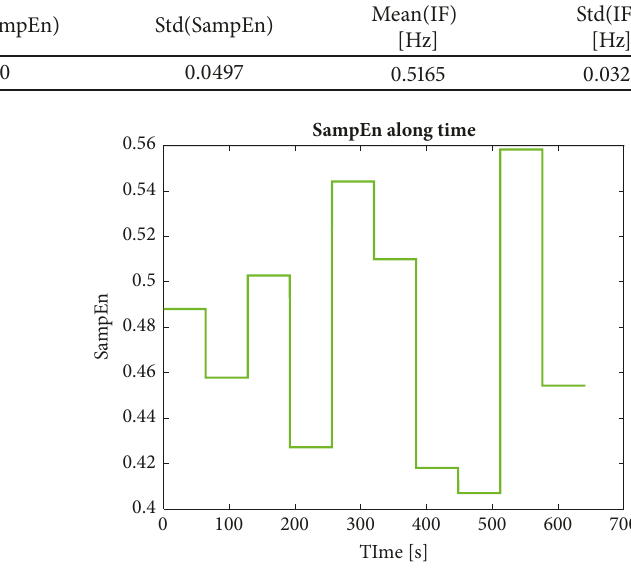
Figure 29: SampEn estimates of the IMFs or modes (IMFs 4) of interest along time.